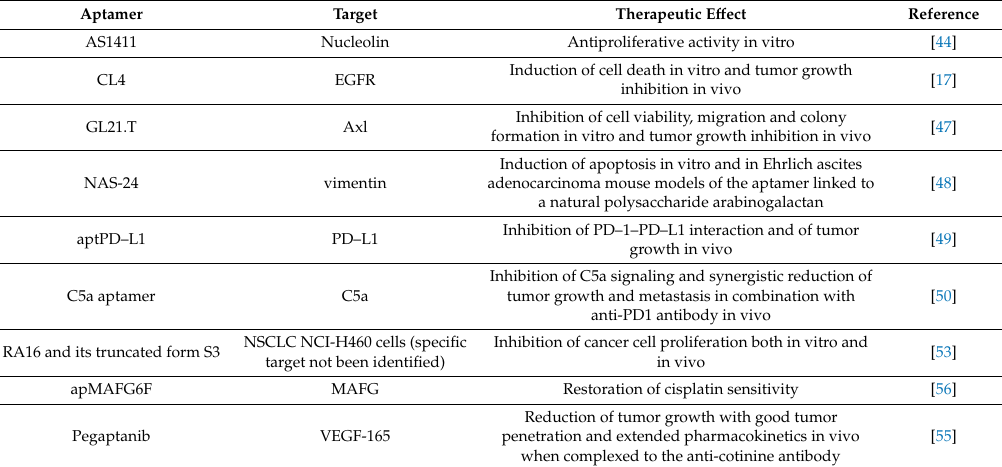
Table 3. Examples of aptamers used for NSCLC